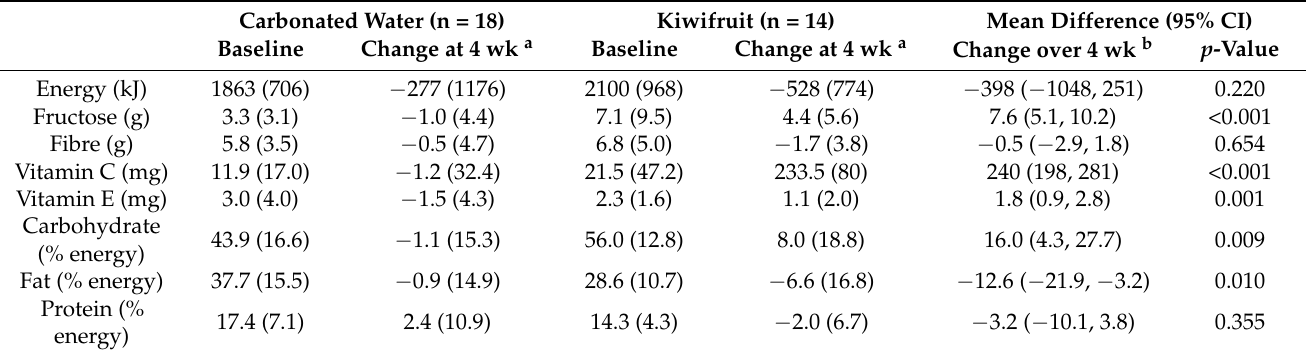
Table 2. Nutrient intake from breakfast before and during intervention (n = 32).